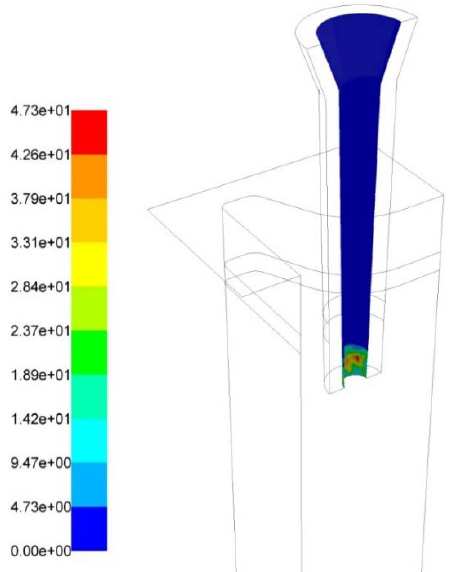
Figure 12. Distribution of wall shear stress (Pa) at 30 mm inner diameter funnel’s inner wall.